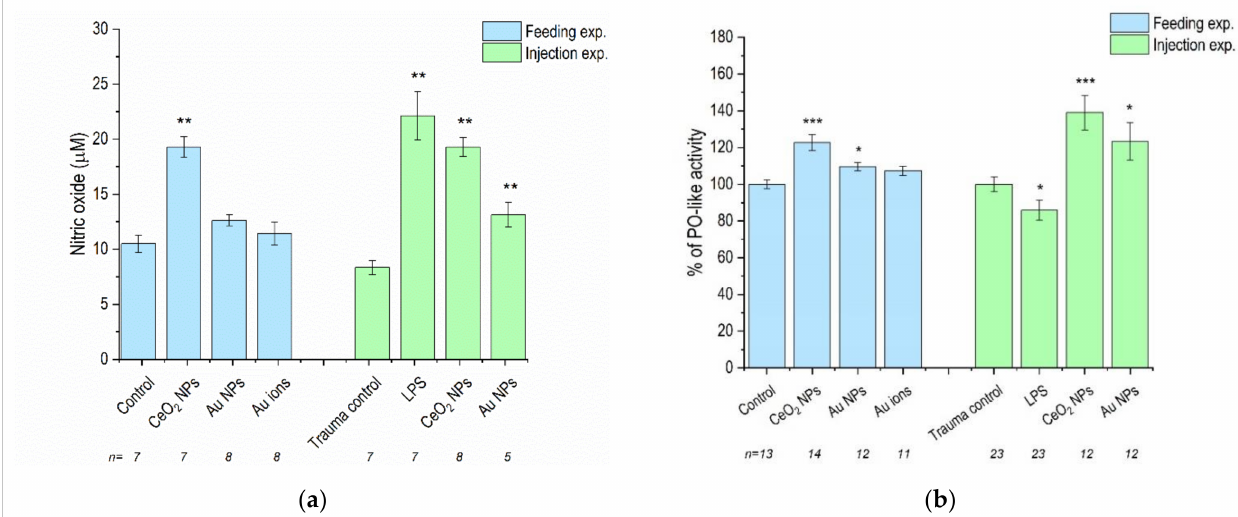
Figure 2. ( a ) Nitric oxide concentrations and ( b ) phenoloxidase (PO)-like activity in P. scaber exposed to CeO 2 NP- and Au NP-spiked leaves (Feeding exp.) and injected with CeO 2 NPs and Au NPs dispersion (Injection exp.). Au ions correspond to AuCl 3 , trauma control are animals injected with dH 2 O and lipopolysaccharide endotoxin (LPS); animals injected with 50 µ g/ µ L LPS. Columns represent the mean ( ± SE). n represents the number of analysed samples. For nitric oxide (NO) measurements, on average, 4–5 animals were grouped into one sample, and for the PO-like measurements, 1–3 animals were grouped into 1 sample. (*) p < 0.05, (**) p < 0.01, (***) p < 0.001 in comparison to control (Kruskal–Wallis test followed by Mann–Whitney U-test).